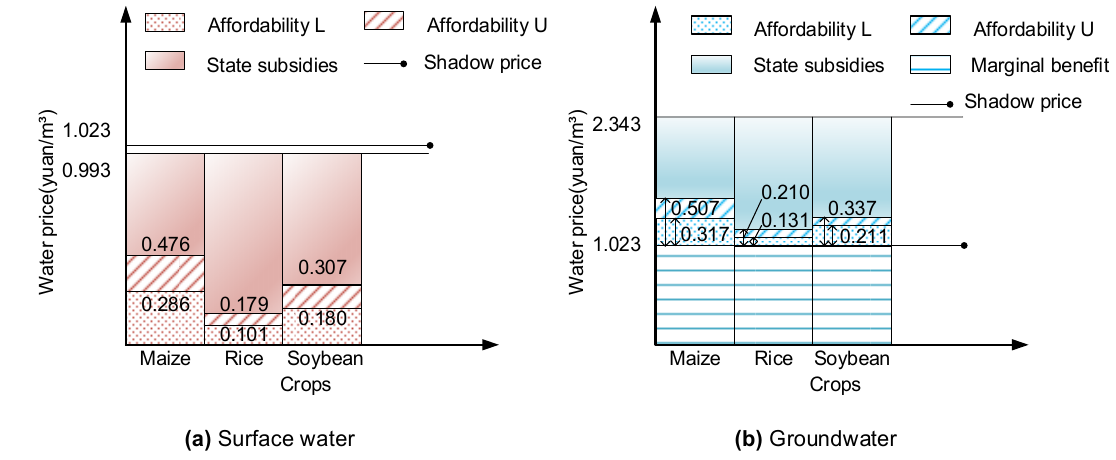
Figure 4. Agricultural irrigation water price composition and subsidies in 2012. U and L indicate the upper and lower bound, respectively, of the range of affordable prices.